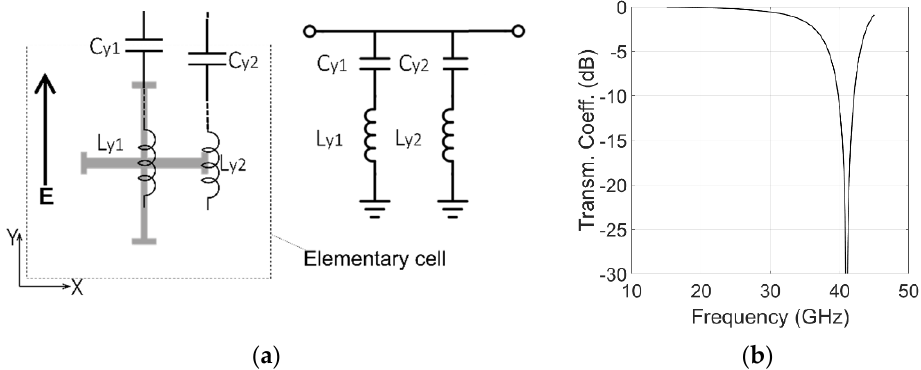
Figure 3. Equivalent circuit model of the Jerusalem cross for a y-polarized impinging wave. ( a ) Equivalent circuit; ( b ) transmission coefficient with Cy1 = 2.3 fF, Ly1 = 3.8 nH, Cy2 = 3.4 fF, Ly2 = 4.3 nH.